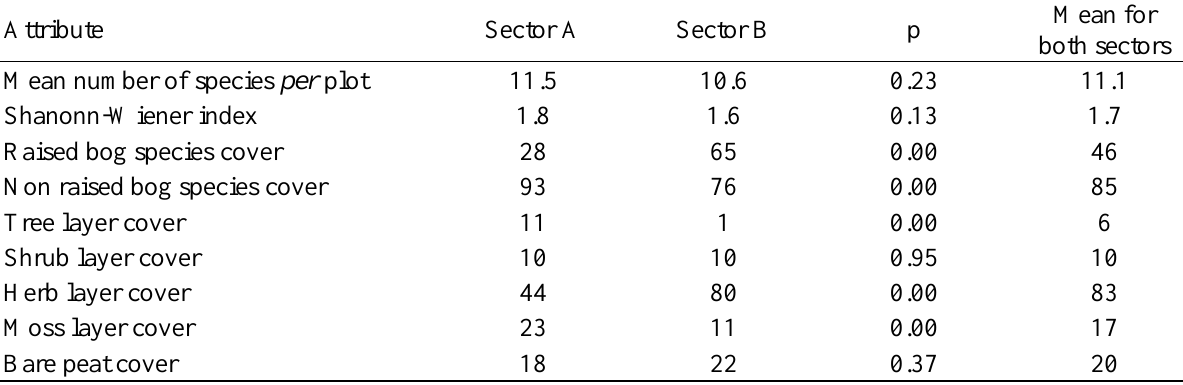
Table 2. Diversity measures and mean cover (%) of plant species typical of raised bogs; other plant species (not characteristic for raised bogs); the tree, shrub and herb layers; and bare peat, in the two extracted sectors of the Bór za Lasem